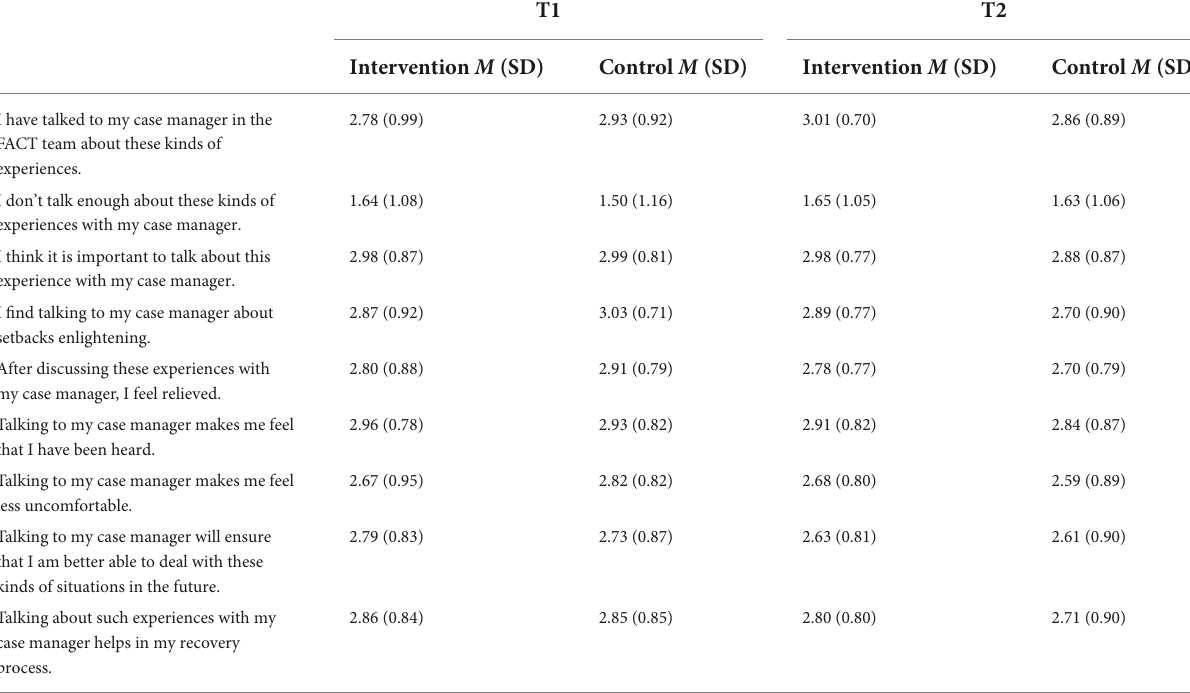
TABLE 5 Clients on social activities and victimization or setbacks at 10- and 20-month follow-up ( N = 326 at T1; N = 315 at